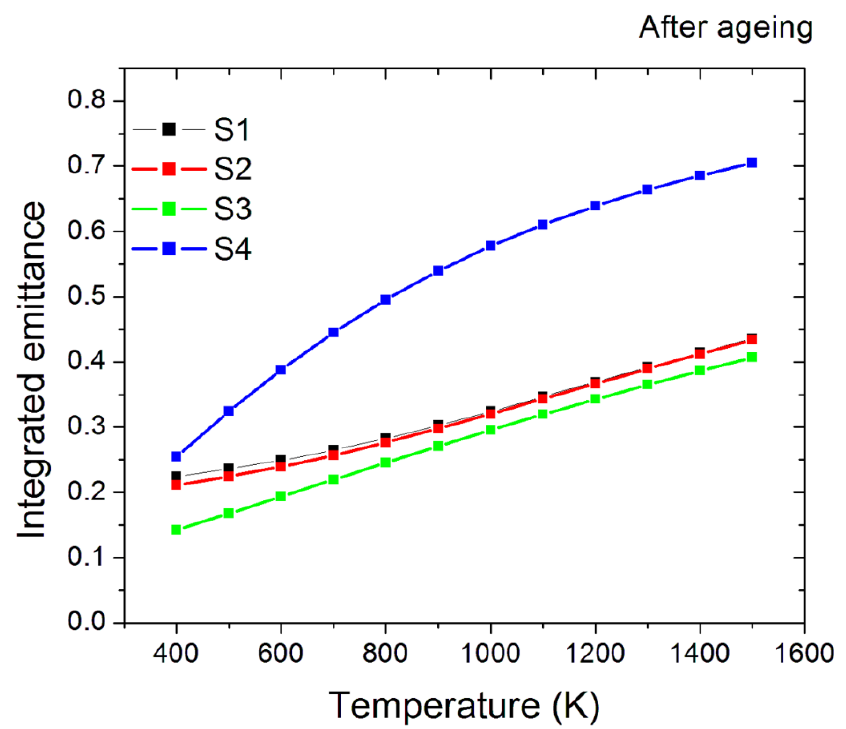
Figure 14. Integrated emittance of the four treated samples and the reference untreated one after the thermal ageing process.